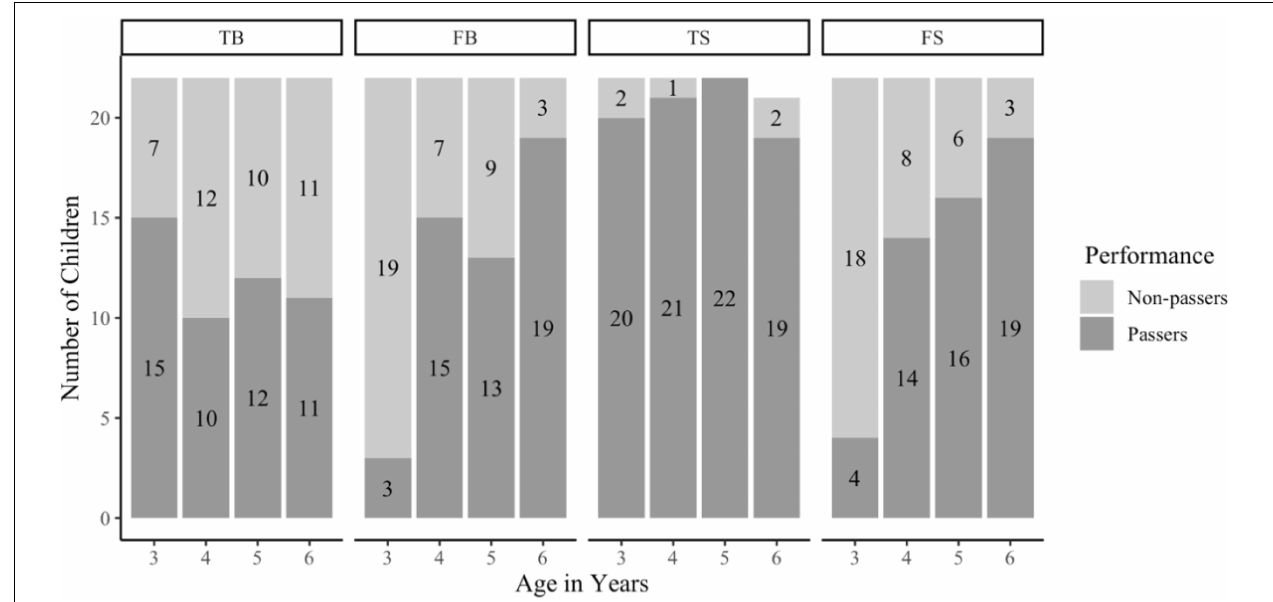
FIGURE 2 | Number of children passing and failing true and false versions of the belief and sign task as a function of age.